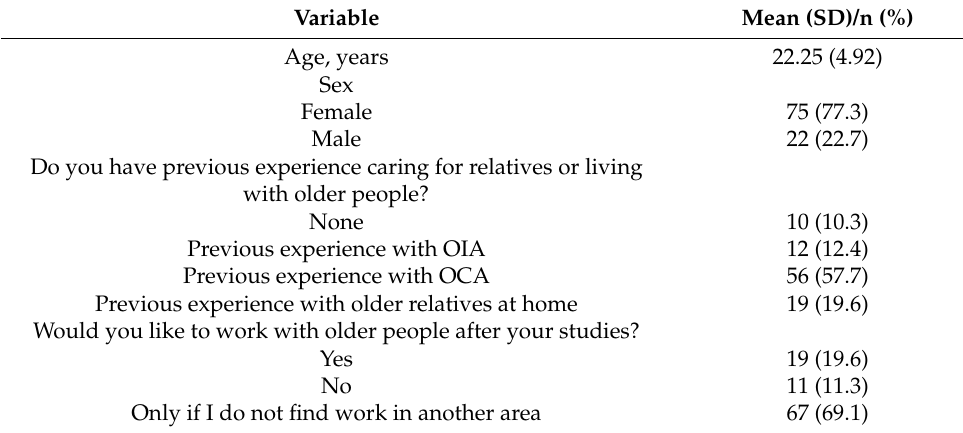
Table 1. Characteristics of the study sample.